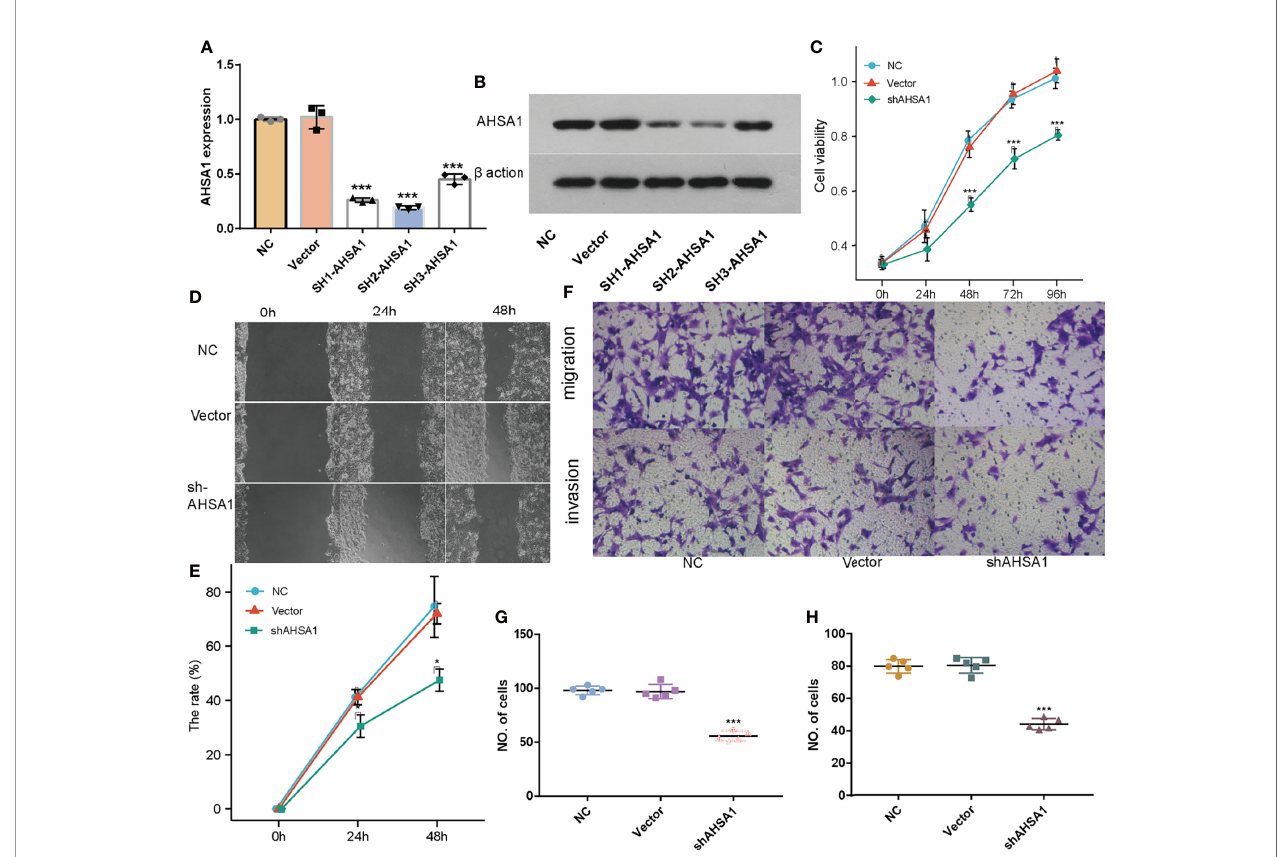
FIGURE 8 | Effects of AHSA1 knockdown on Huh7 cell proliferation and migration. Real time PCR (A) and Weston blot (B) determine the ef fi ciency of AHSA1 knockdown in Huh7 cells. (C) Huh7 cell proliferation was detected by CCK8 assays. (D, E) . Cell migration ability was examined by cell scratch assay. (F) Tranwell analysis was preformed to determine the cell migration (G) and invasion (H) . *p<0.05,